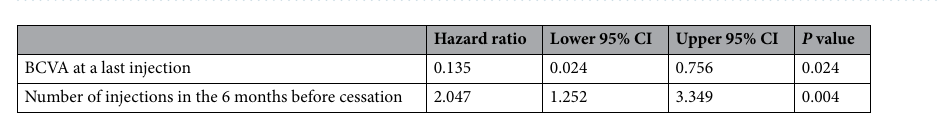
Figure 2. Kaplan–Meier survival curves of recurrence after the cessation of treatment in patients with age- related macular degeneration. ( a ) The estimated recurrence rate was 33% at 12 months and 48% at 24 months, respectively. Patients with ( b ) best corrected visual acuity (BCVA) < 0.1 logMAR at cessation and ( c ) number of injections in the 6 months before cessation ≥ 3 had higher chance of recurrences.